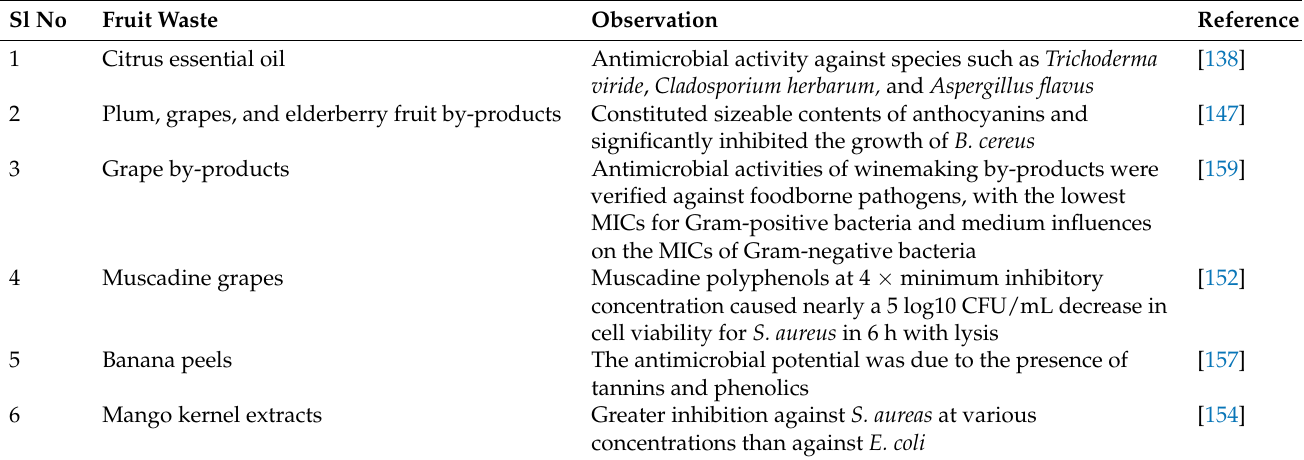
Table 3. Antimicrobial properties of bioactive compounds extracted from various fruit